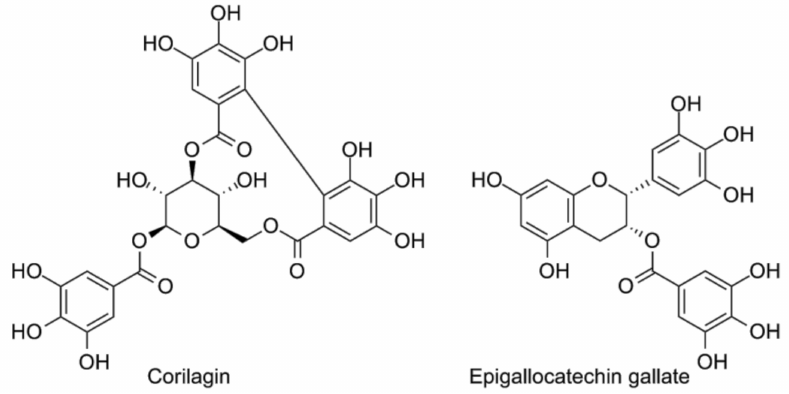
Figure 4. The polyphenols corilagin (left) and epigallocatechin gallate